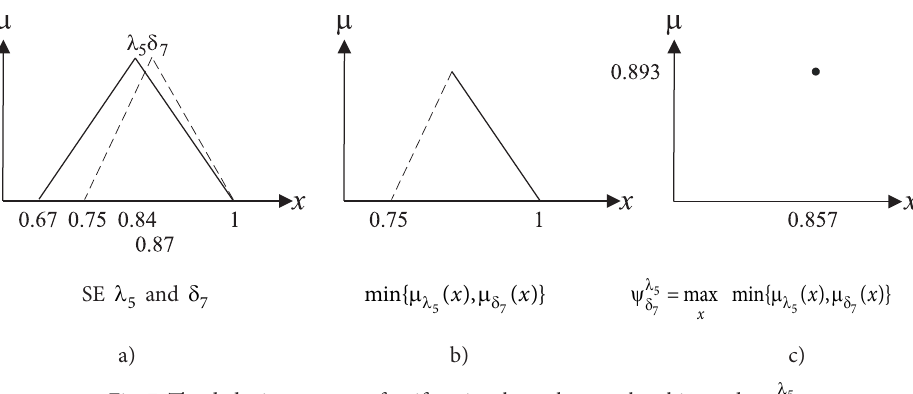
Fig. 7. The deducing process of uniformity about the membership grade